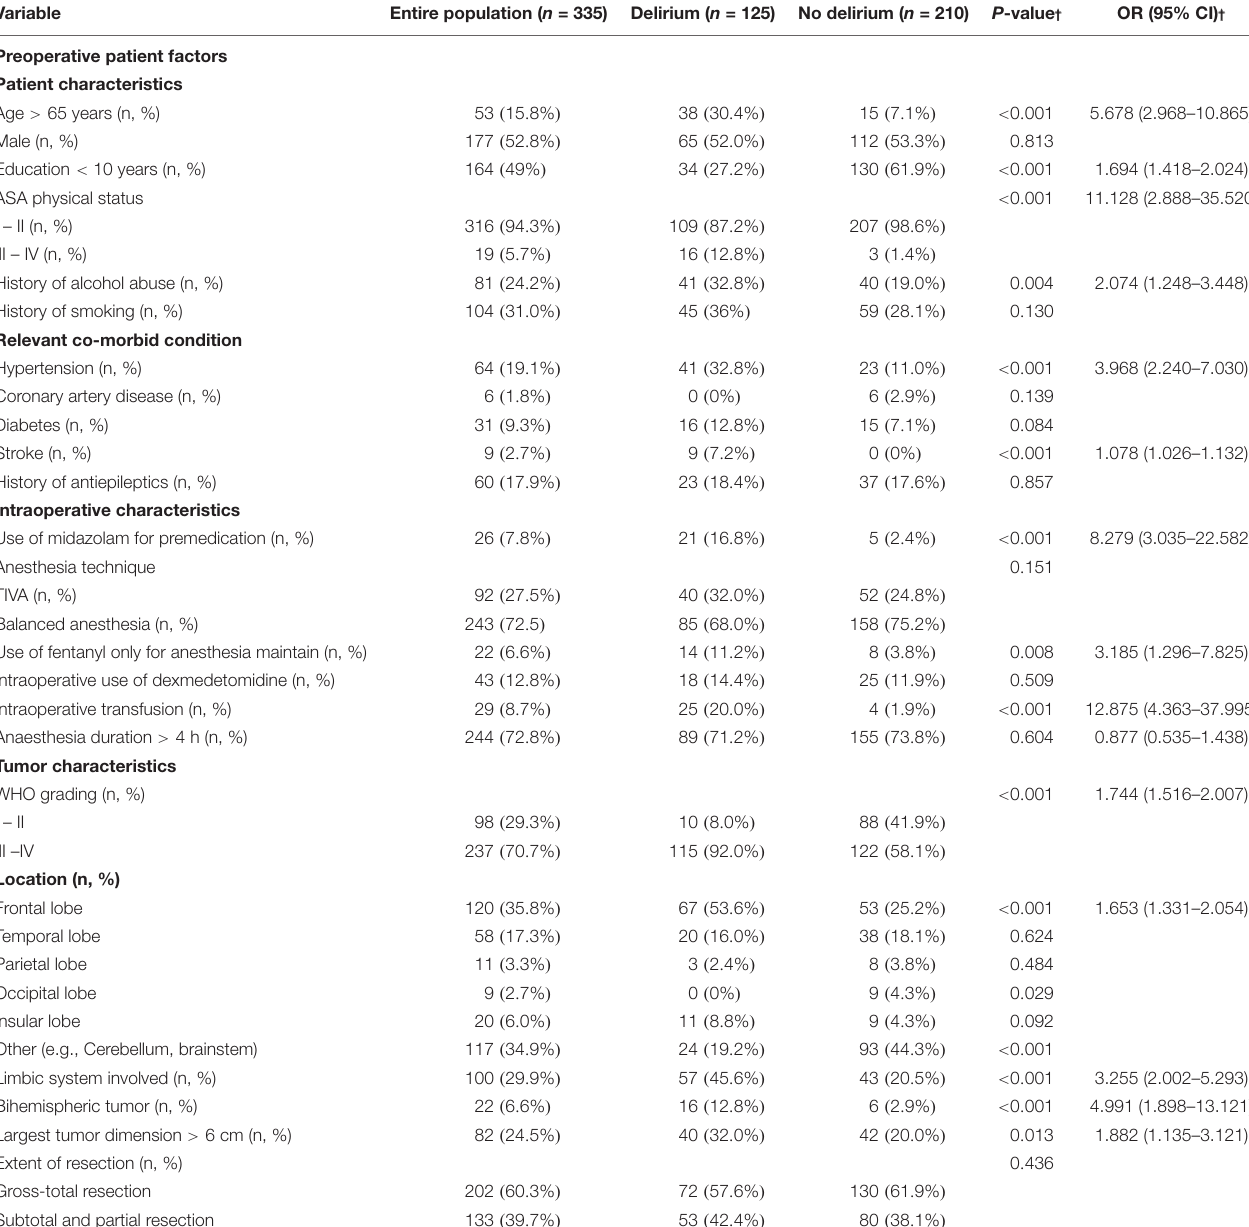
TABLE 1 | Univariable logistic regression of preoperative patients’ factors, intraoperative patients characteristics and tumor characteristics.